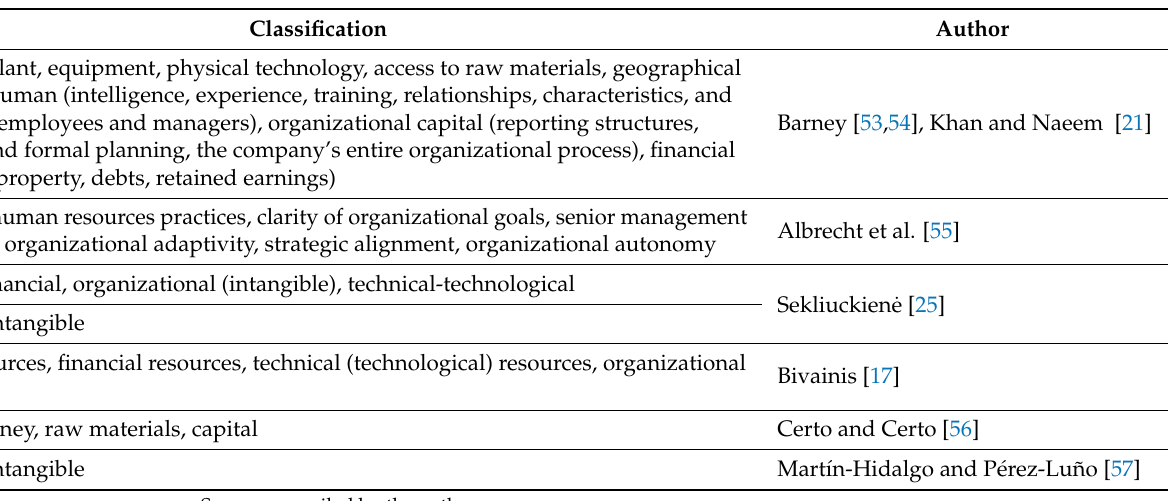
Table 4. Organization’s resources classification